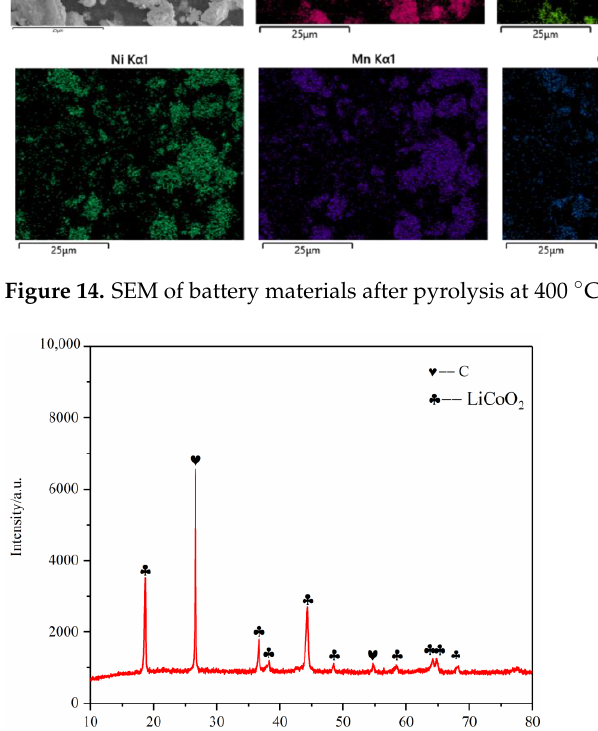
Figure 15. XRD of battery materials after pyrolysis at 400 °C.